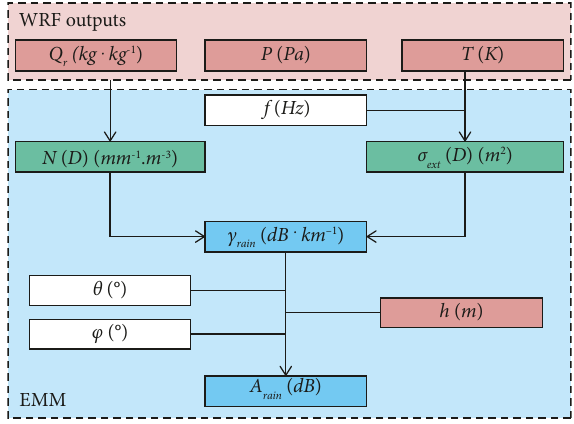
Figure 3: Overview of the EMM from the outputs generated by WRF.